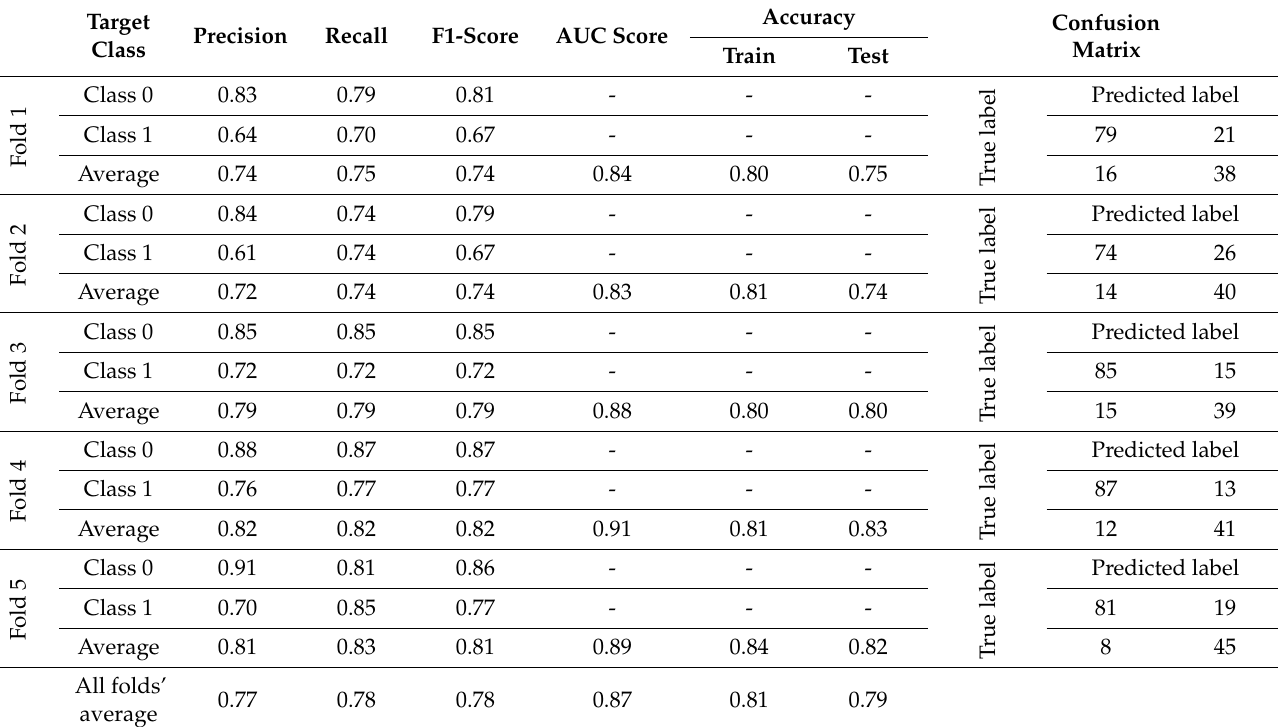
Table A1. ANN model’s performance for the five-fold